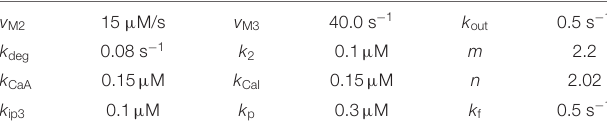
TABLE 1 | Model parameters for which all results are computed unless otherwise